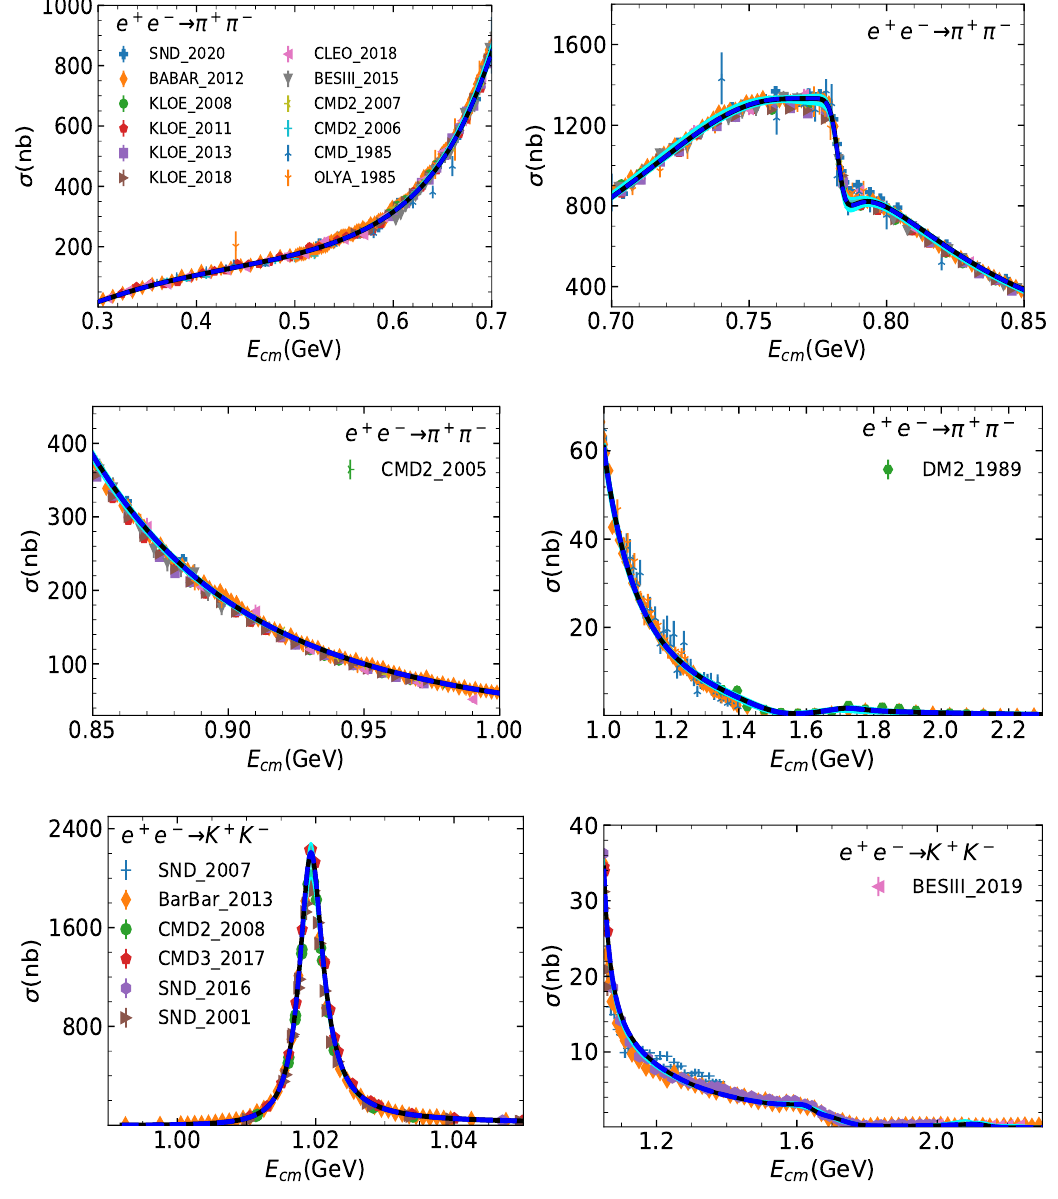
Figure 2 . Fit to the cross sections of e + e − → π + π − , K + K − of Fit I (dashed blue line) and Fit II (solid black line). The cyan bands correspond to the uncertainty of Fit II. The top four graphs are for e + e − → π + π − ,the bottom two graphs are for e + e − → K + K − . The experimental data displayed for e + e − → π + π − are from BaBar [69], KLOE [70–73], SND [74], BESIII